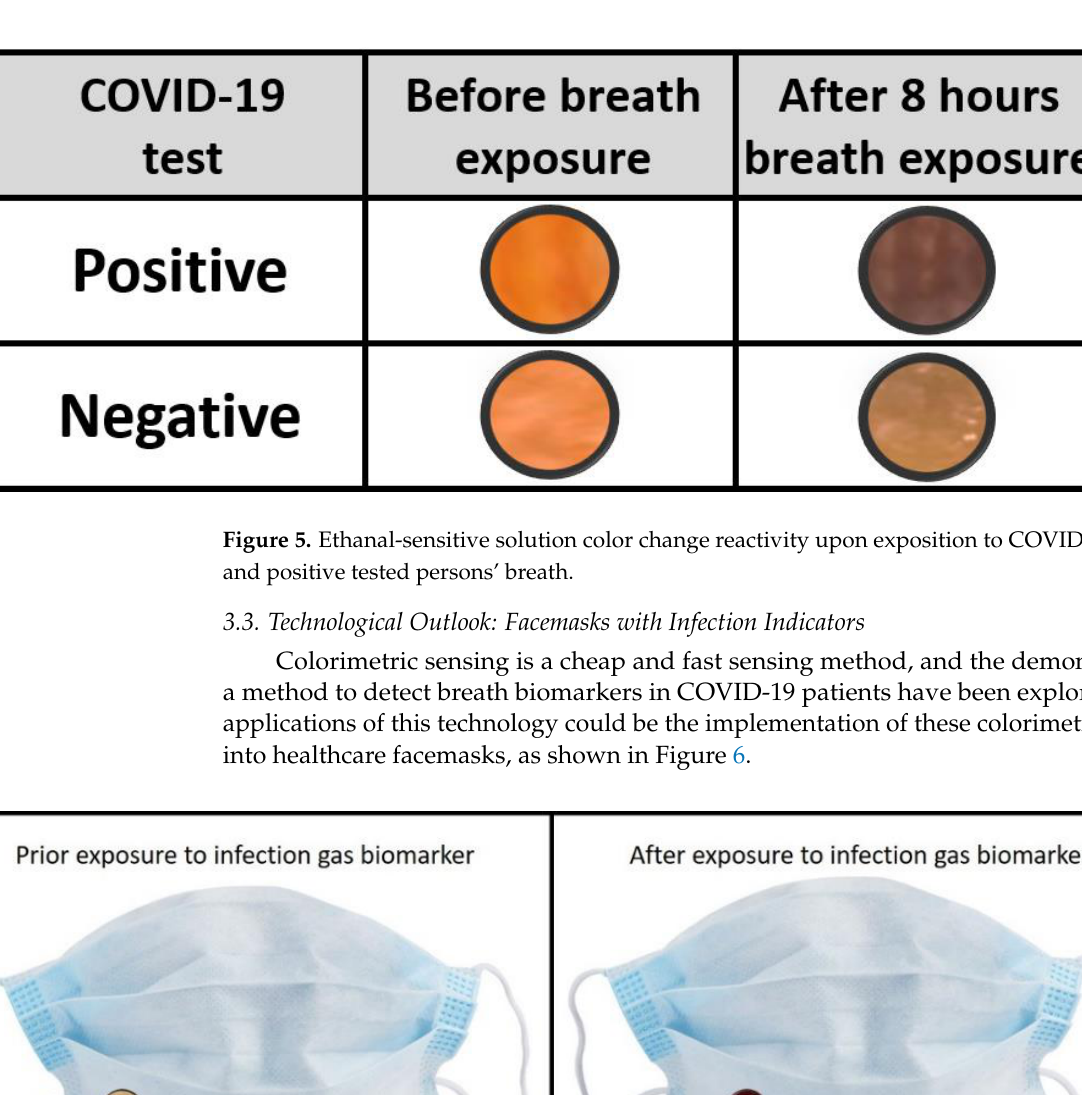
Figure 6. Example of potential technological outlook for the explored sensing method.